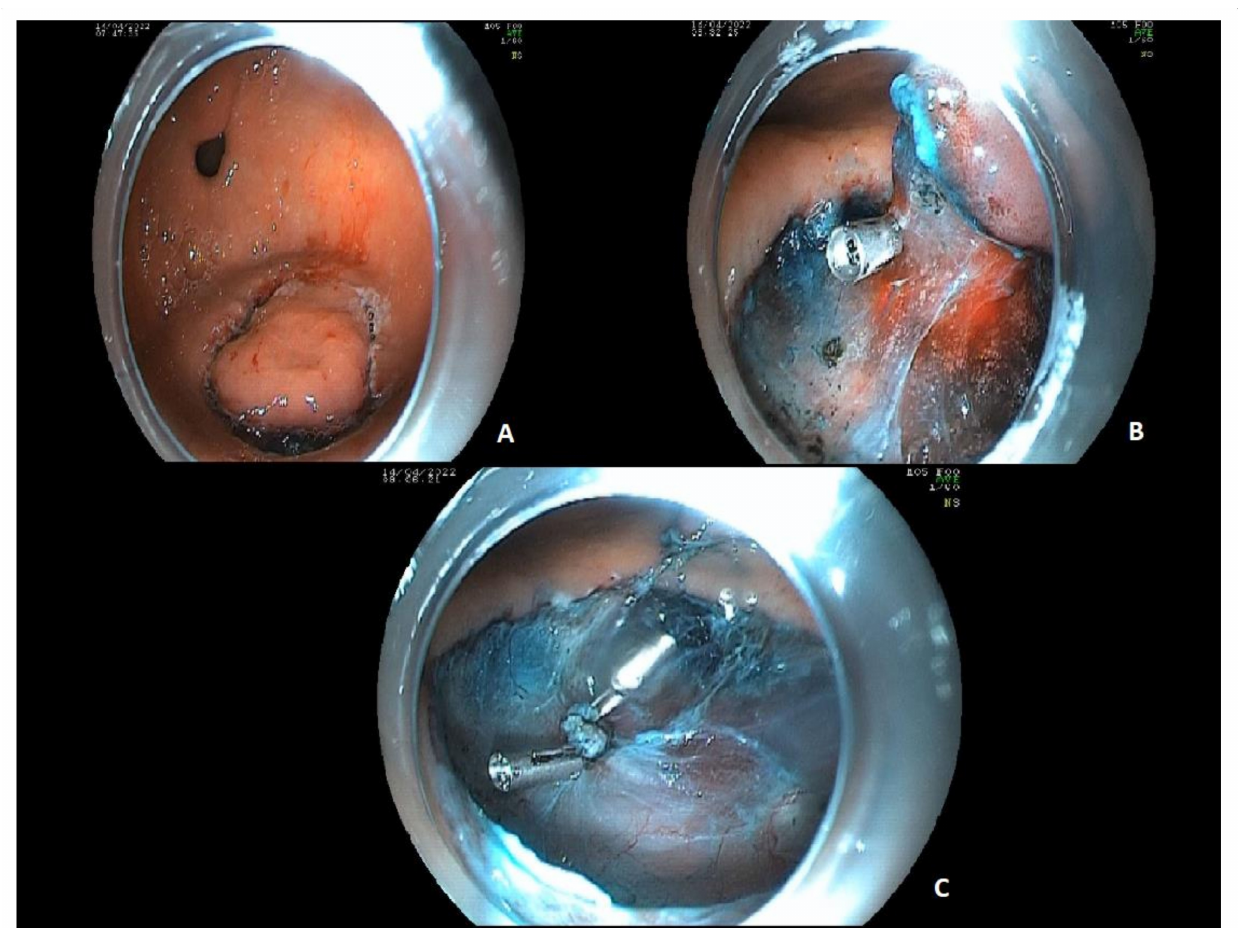
Figure 4. Traditional ESD of a high-dysplasia lesion, 20 mm in size, located in the gastric antrum. In ( A) the mucosal layer surrounding the lesion is already pre-cut, after the injection of a lifting agent, which can be seen in blue. In ( B ) most of the lesion is already dissected. A clip had been positioned to stop arterial bleeding which occurred during the dissection procedure. The lesion can be seen in the upper part of the figure, almost all dissected. In the lower part of the figure the submucosal layer can be seen. In ( C ) the dissection is completed. The clips were positioned during the ESD to stop an arterial bleed. The submucosal layer is intact after the